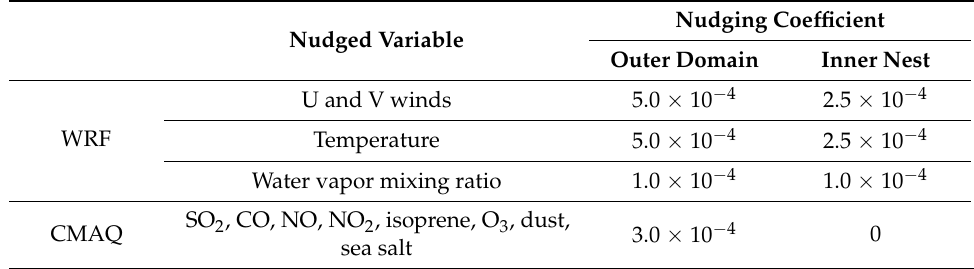
Table 2. Nudged variable and nudging